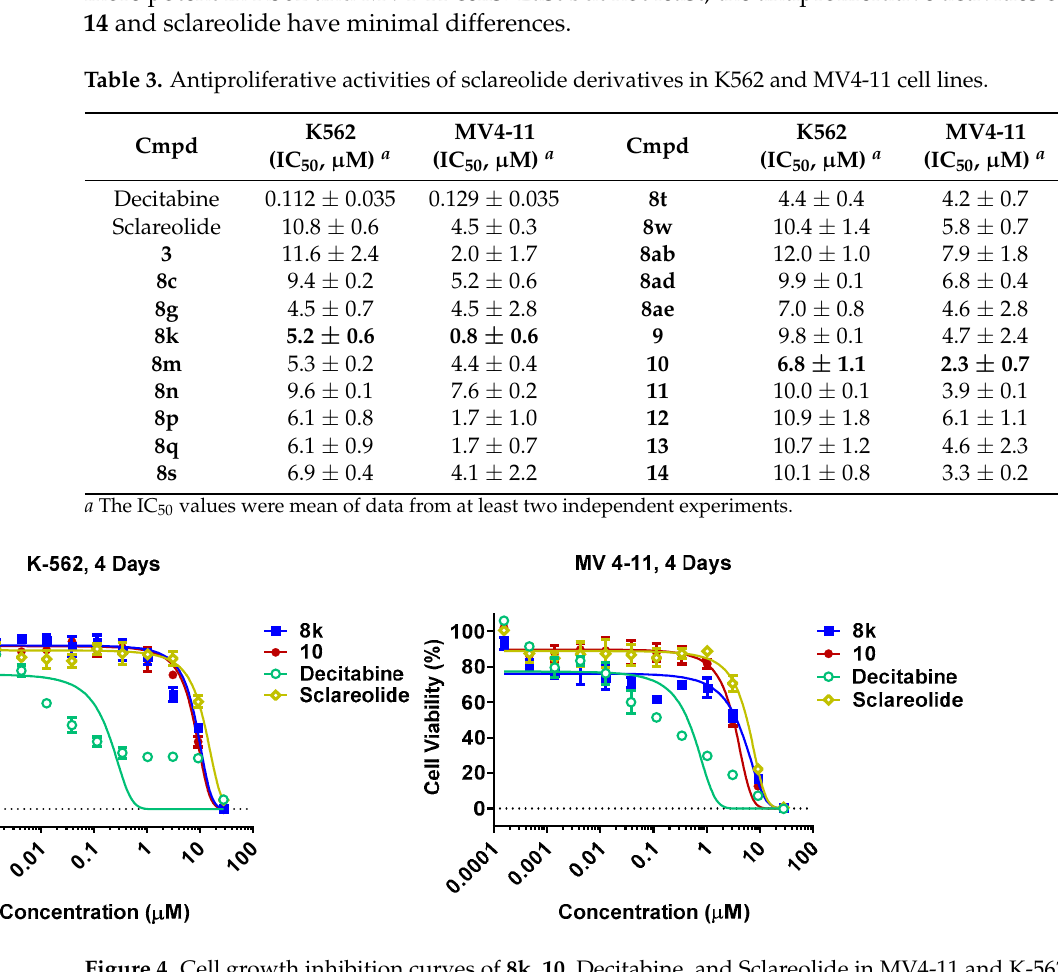
Table 3. Antiproliferative activities of sclareolide derivatives in K562 and MV4-11 cell lines